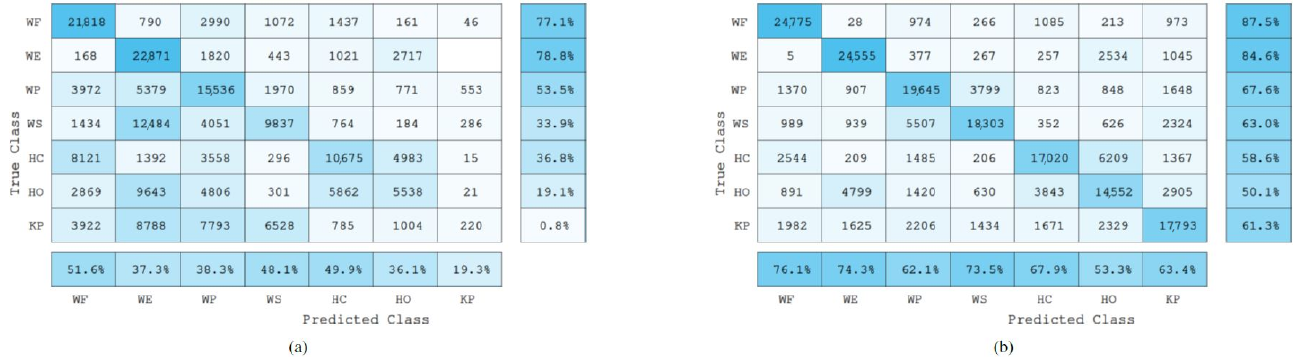
Figure 11. Bilinear models-based confusion matrices of the seven gestures collected using EMG data only ( a ), and EMG and IMU data ( b ) from all testing subjects. The numbers inside each cell represent the number of sample points classified. The last row from each confusion matrix represents the precision score percentages of each class. Similarly, the last column represents the recall score percentages of each